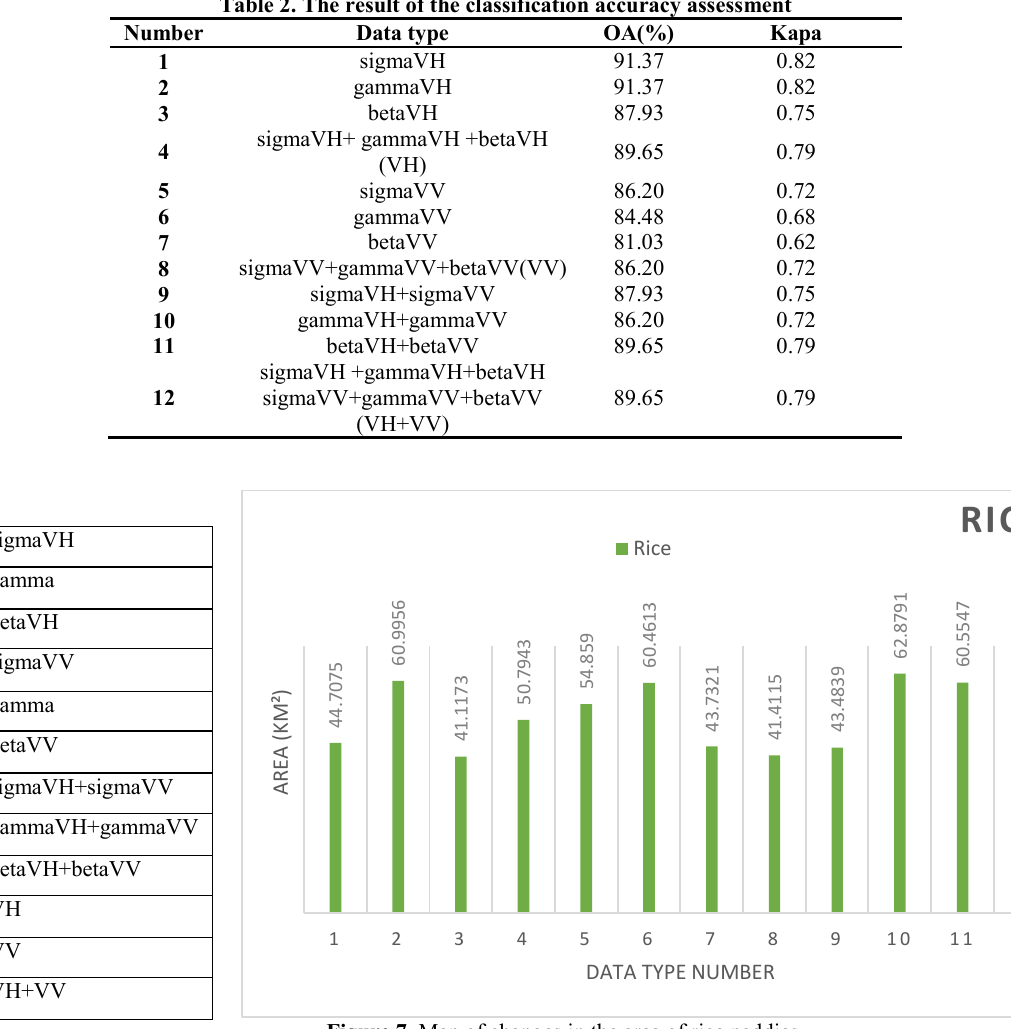
Figure 7. Map of changes in the area of rice